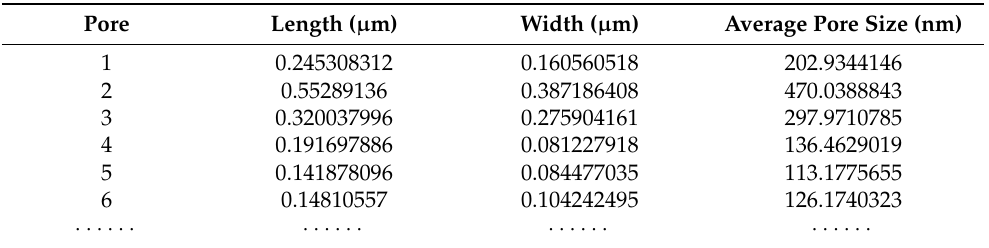
Table 1. Parameters of each organic pore obtained from sample SK1-S-1 after PCAS software pro- cessing. Length: longest diameter; width: shortest diameter; average pore size: average diameter (longest+ shortest)/2.